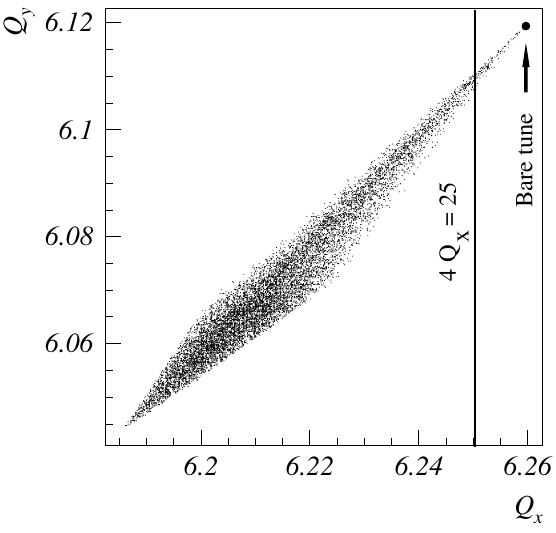
FIG. 3. Tune diagram with ‘‘footprint’’ of the initial ensemble of particles in 6D phase space (‘‘frozen’’ longitudinal motion).